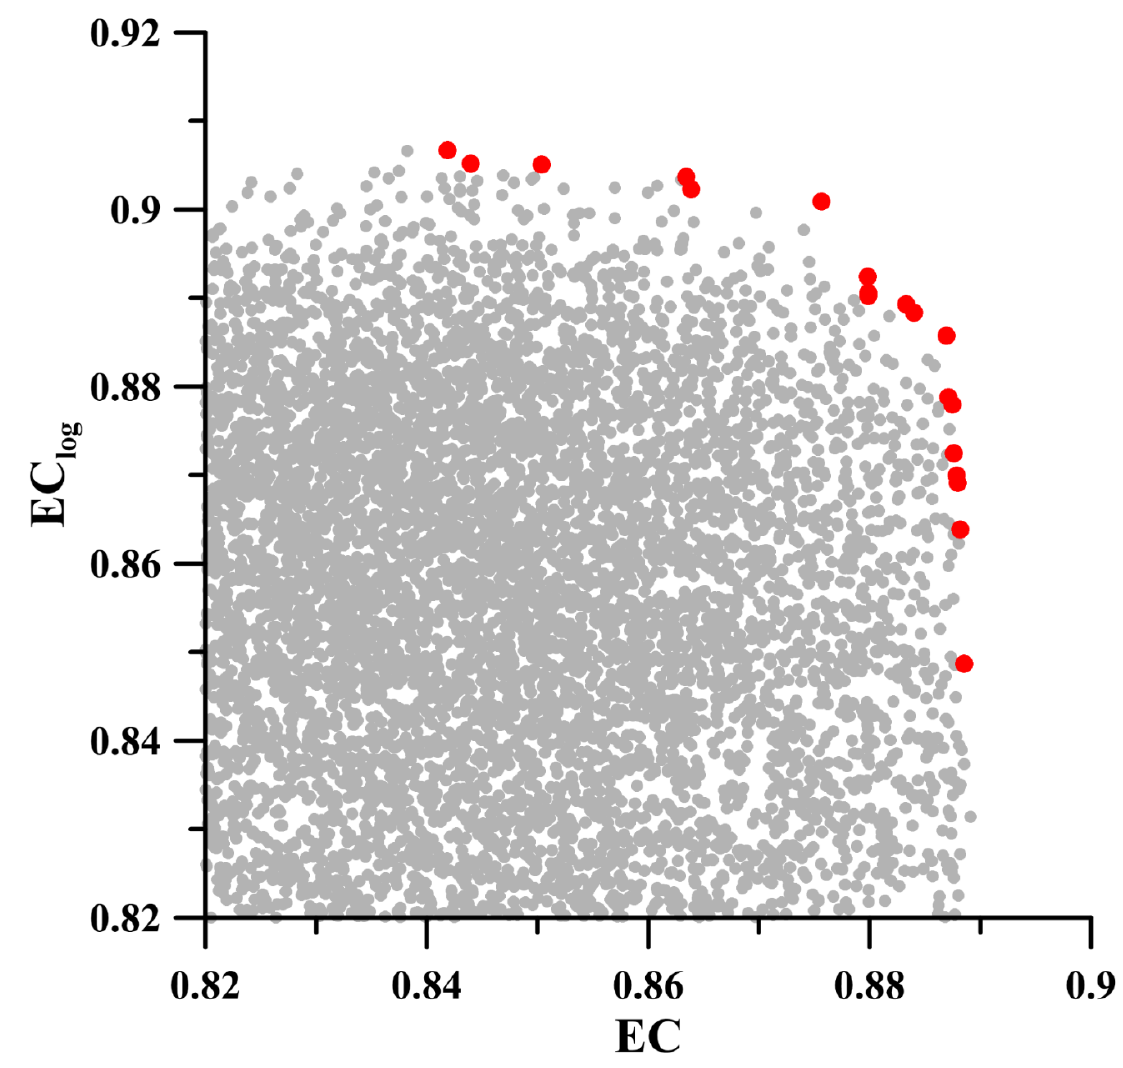
Figure 4. Pareto front of 100,000 sets of parameters based on efficiency coefficient (EC) and EC log . There are 23 non-inferior parameter sets, indicated by the red dots.